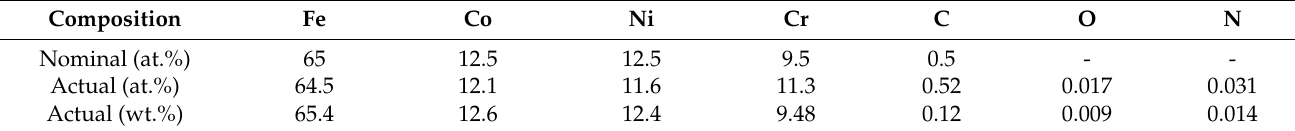
Table 1. Chemical composition of the as-produced alloy.